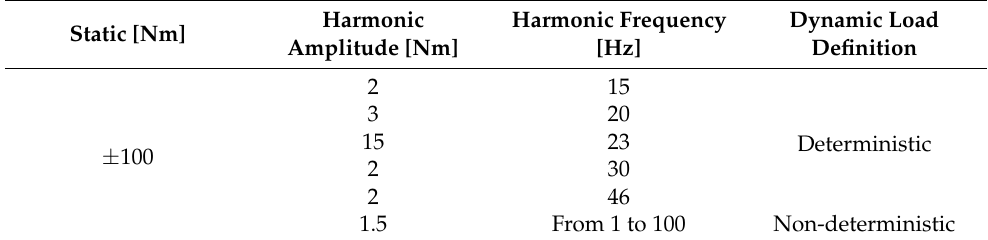
Table 2. Loads on vertical stabilizer FLA at VNE (derived from CFD analyses by Airbus Helicopters, worst-case scenario, all positions). Harmonic Harmonic Frequency Static [Nm] Amplitude [Nm] [Hz]